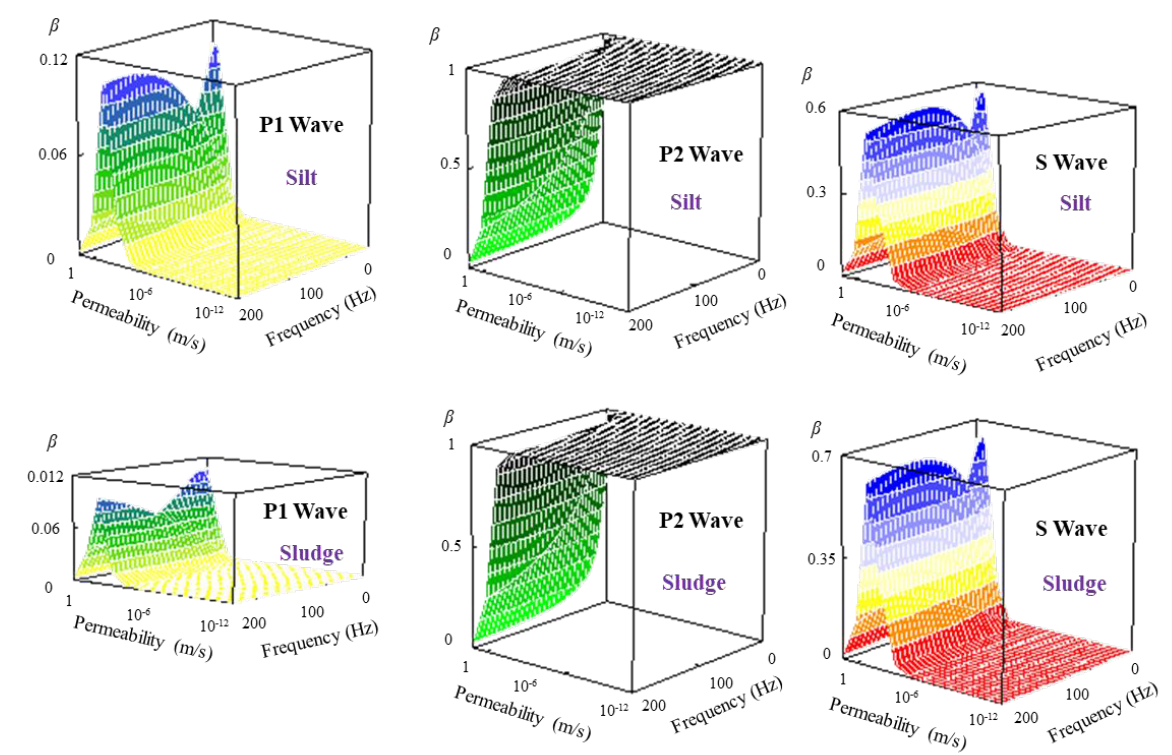
Figure 2. Relations of permeability, frequency and attenuation coefficients of three waves in four saturated soils.